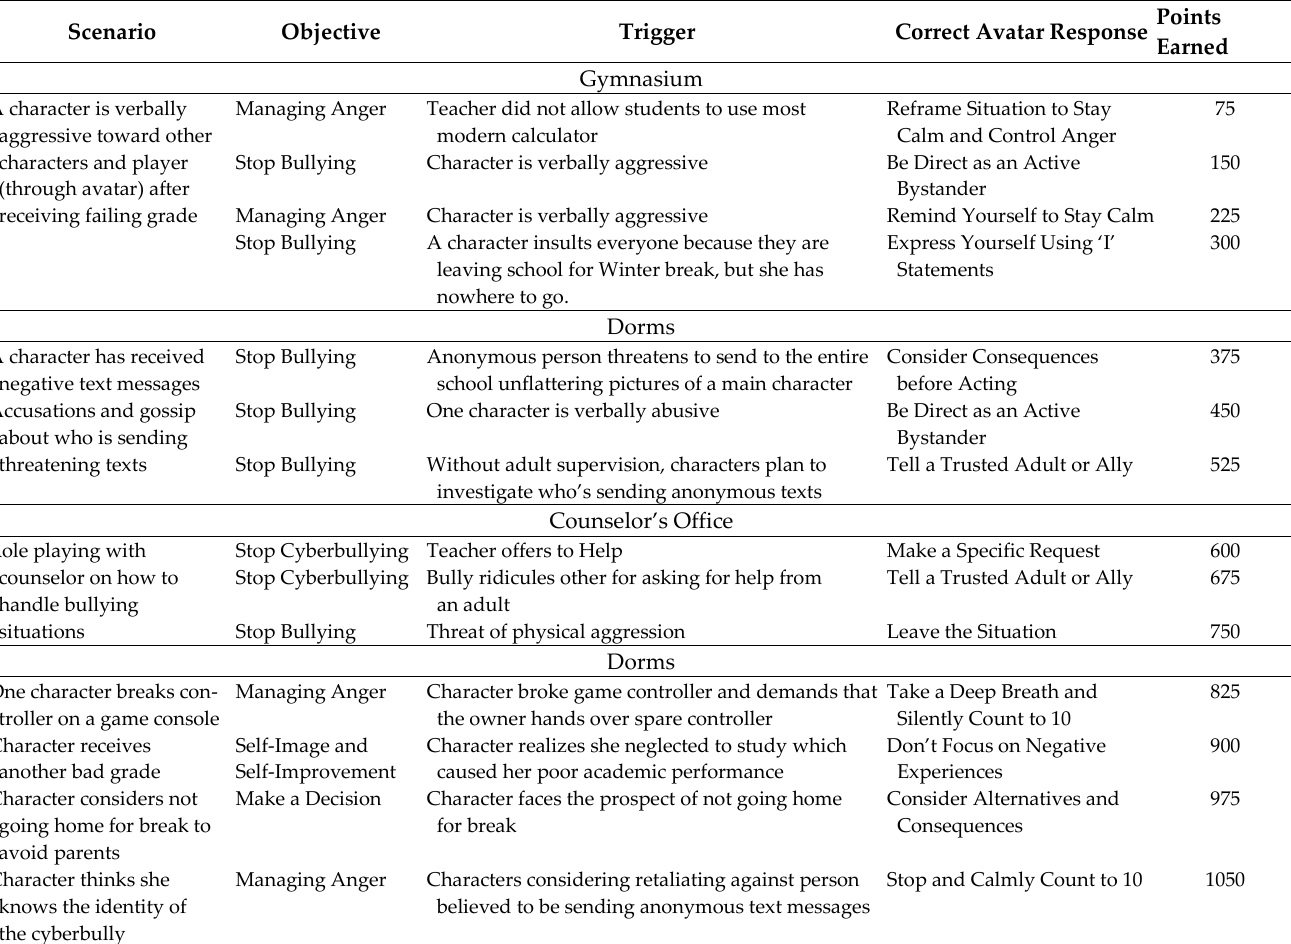
Table 2. Interactive Video Game Branched Scenarios for Module 3: Bullying and Cyberbullying.